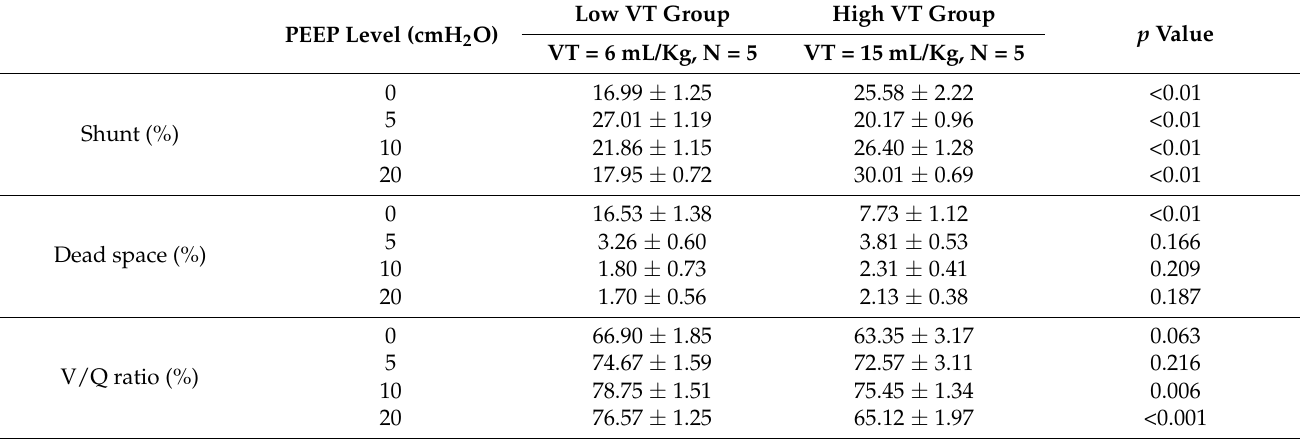
Table 1. Changes in lung shunt, dead space, and ventilation/perfusion (V/Q) ratio under the influence of tidal volume and PEEP.